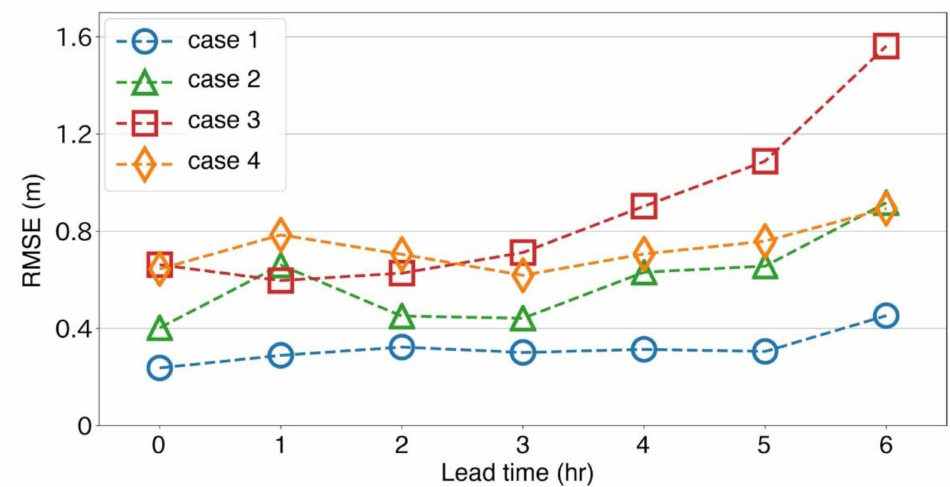
Figure 9. RMSEs for the four flood cases at 0- to 6-h lead times. RMSEs were calculated over ± 24 h centered at the time of